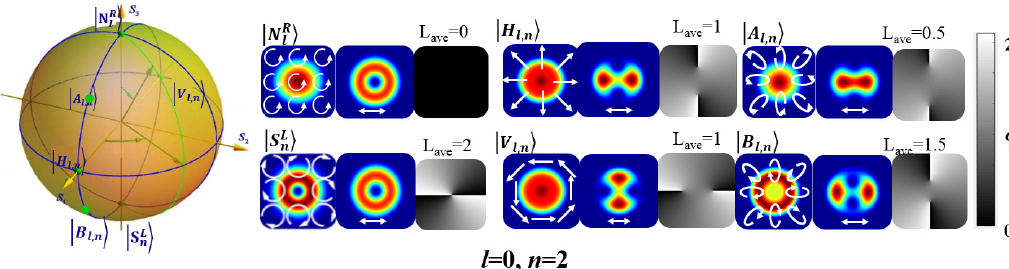
Figure 4. Intensity profiles, polarization states and phase distributions of superimposed modes when (cid:96) = 1 and n = 2. The north pole N R and south pole S L n represent orthogonal circularly-polarized modes with topological charges of l and n ; The points H l , n and V l , n represent the two points on the equator; The A l , n and B l , n points represent the two modes with 0.5 and 1.5 average OAM values, respectively.